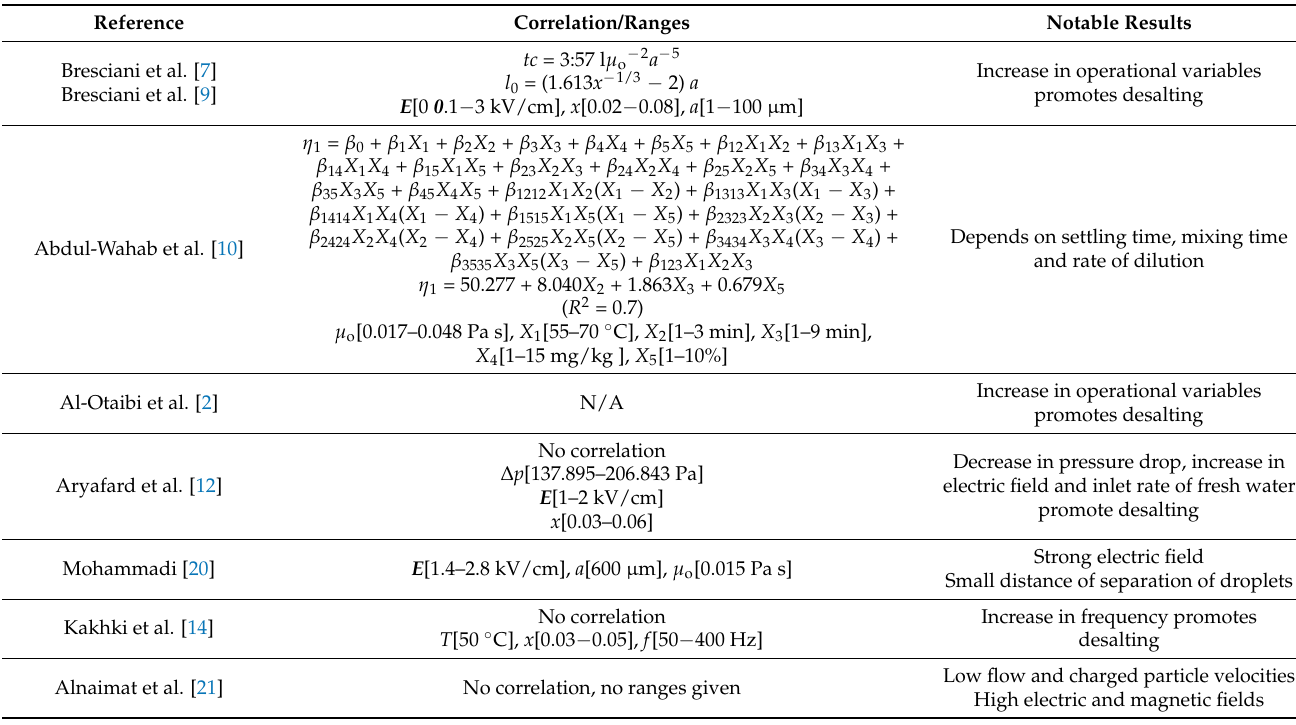
Table 1. Summary of proposed models for desalting of crude